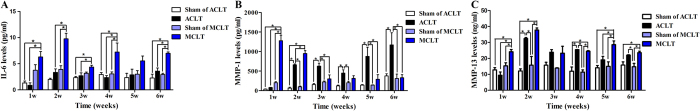
ELISA results of synovial fluid analysis (A) ELISA results of IL-6. The IL-6 level in the MCLT group was higher than in the ACLT group from 1 to 6 weeks after surgery, especially at 1 and 2 weeks (P values, 1 W, P < 0.001; 2 W, P < 0.001; 3 W, P = 0.032; 4 W, P < 0.001; 5 W, P = 0.001; 6 W, P < 0.001). (B) ELISA results of MMP-1. The MMP-1 level was higher in the MCLT compared with the ACLT group 1 and 2 weeks post-surgery, although the ACLT group levels were higher from 3 to 6 weeks (P values, 1 W, P < 0.001; 2 W, P = 0.009; 3 W, P = 0.004; 4 W, P = 0.194; 5 W, P < 0.001; 6 W, P < 0.001). (C) ELISA results of MMP-13. The MMP-13 levels in the MCLT groups were higher than in the ACLT group 1 week after the operation (P values. 1 W, P = 0.02). (n = 8, *p < 0.05).